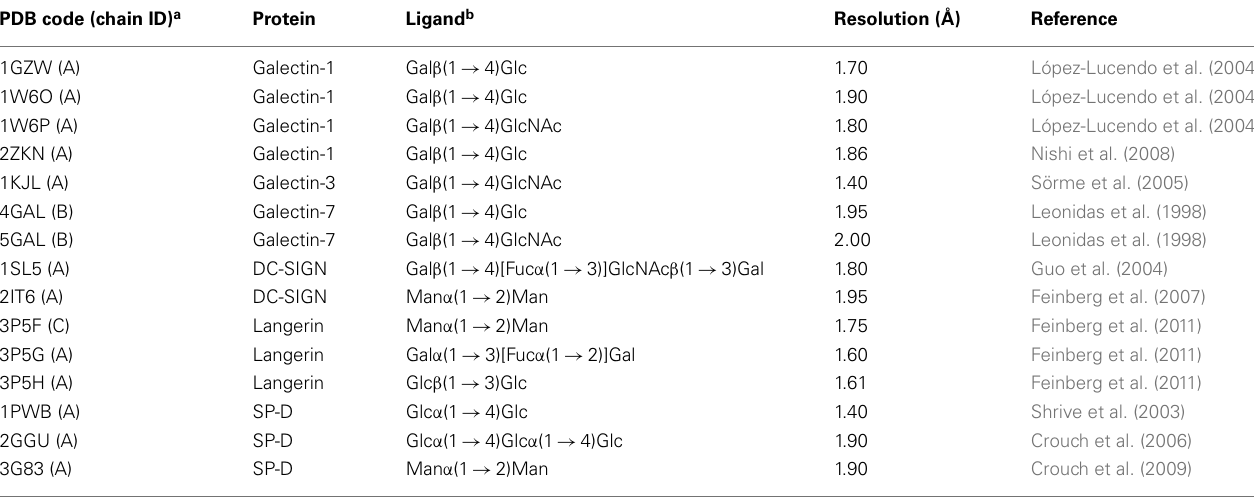
Table 1 | Carbohydrate–lectin complexes selected for the test